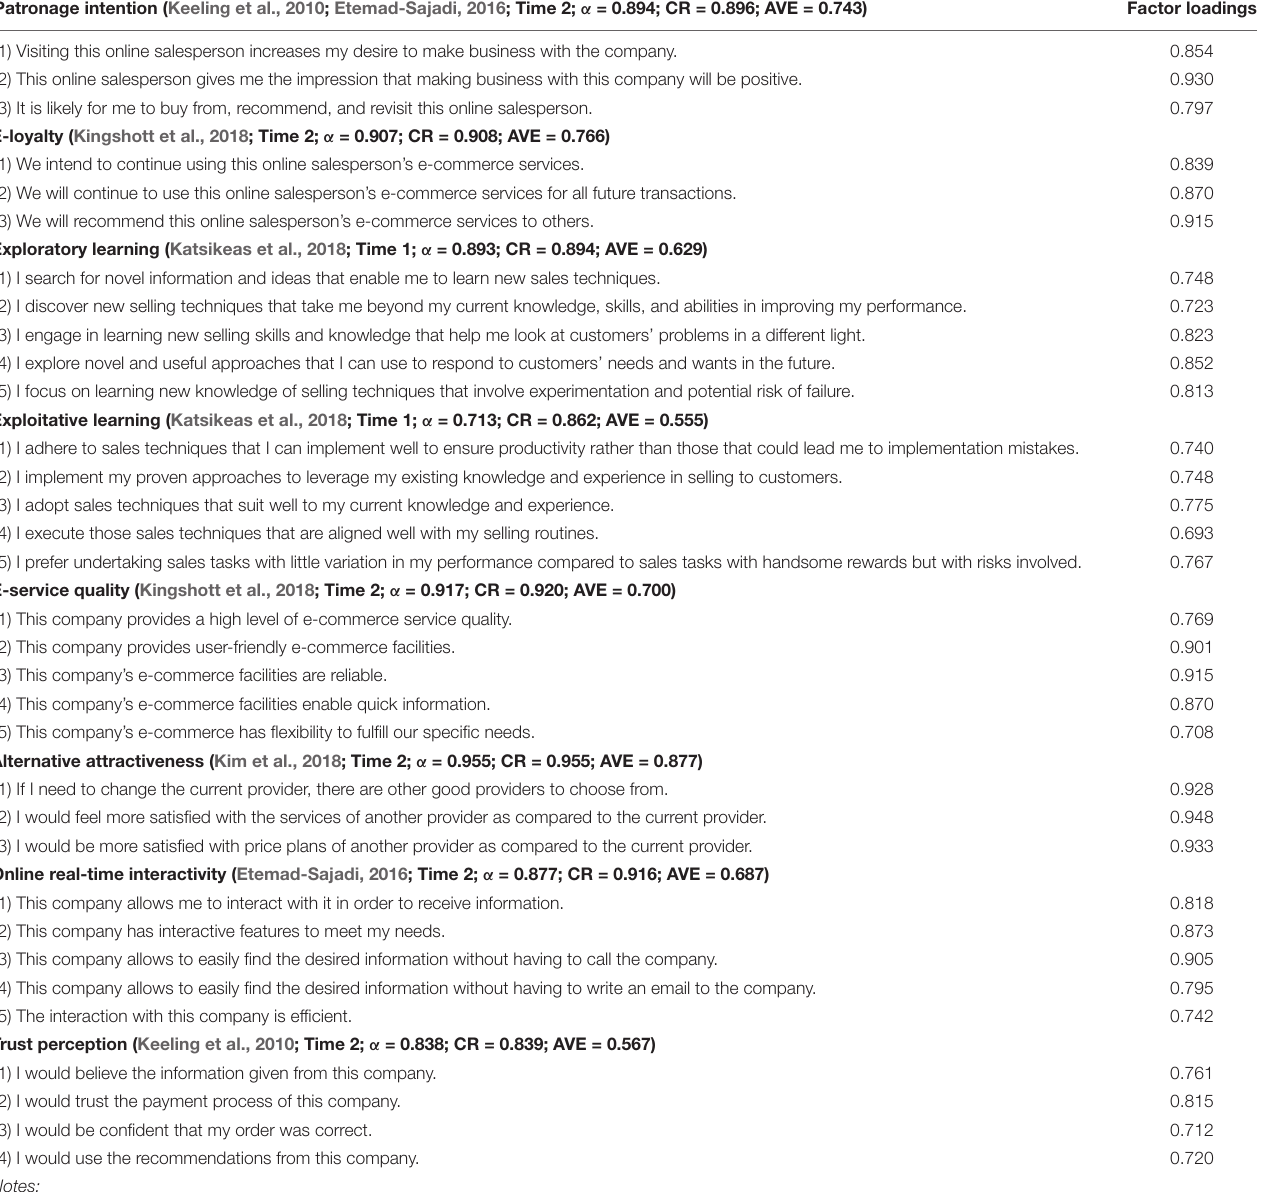
TABLE 2 | Construct reliability and